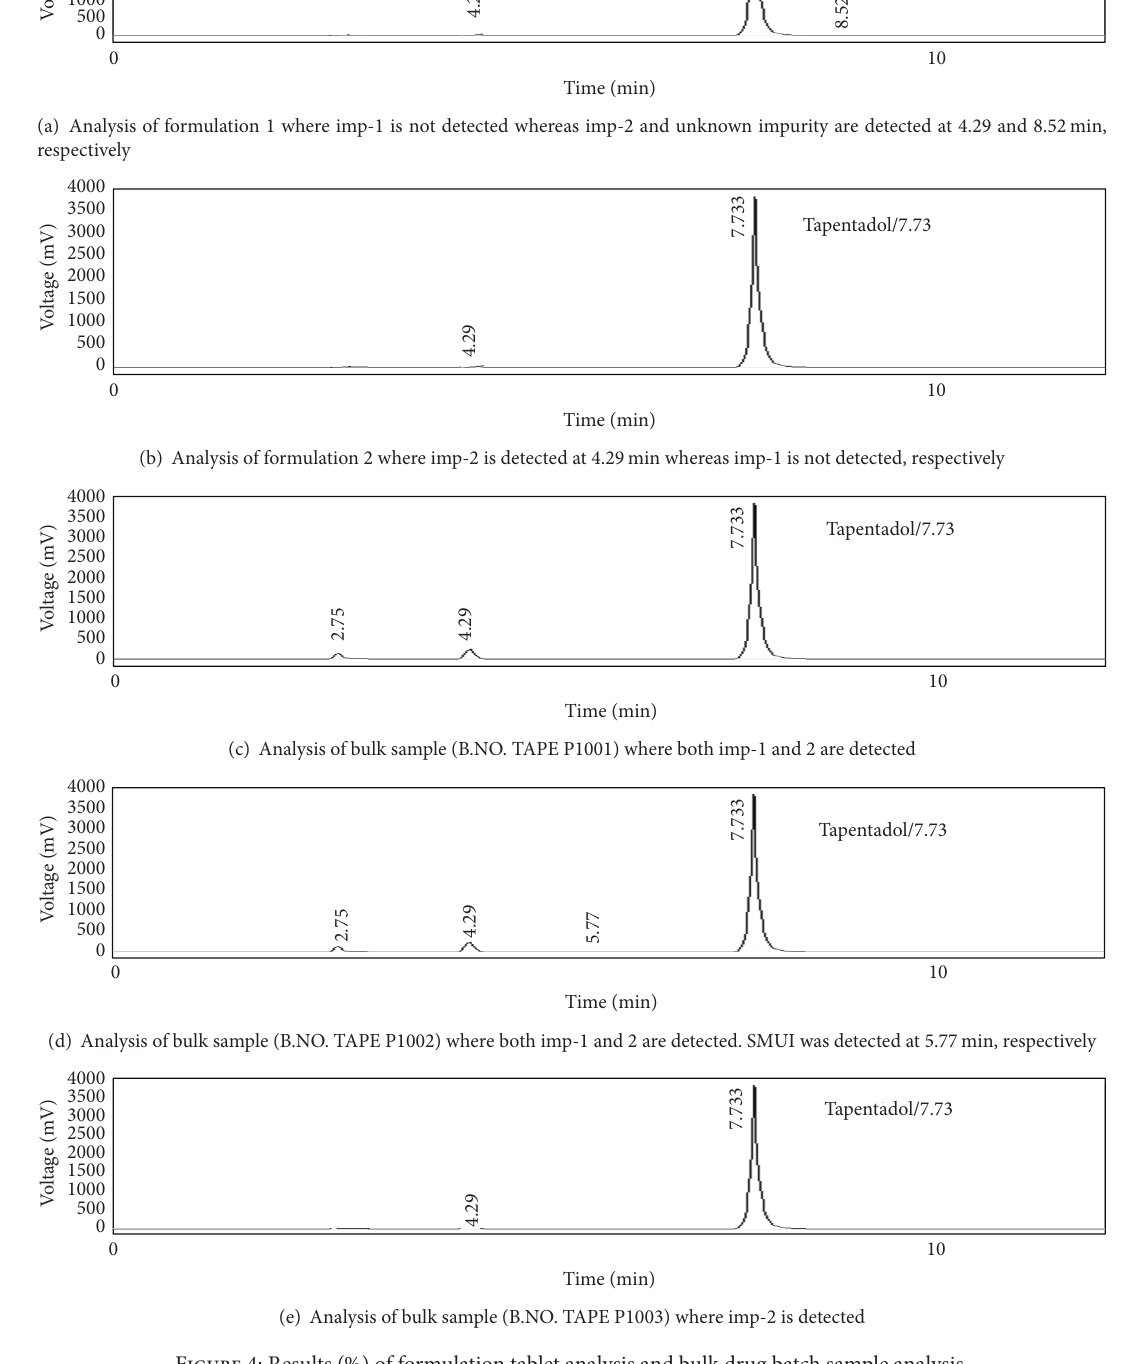
F 4: Results ( ) of formulation tablet analysis and bulk drug batch sample %